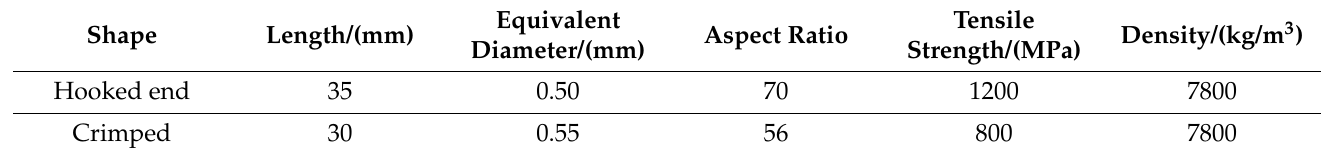
Table 3. Characteristics of the steel